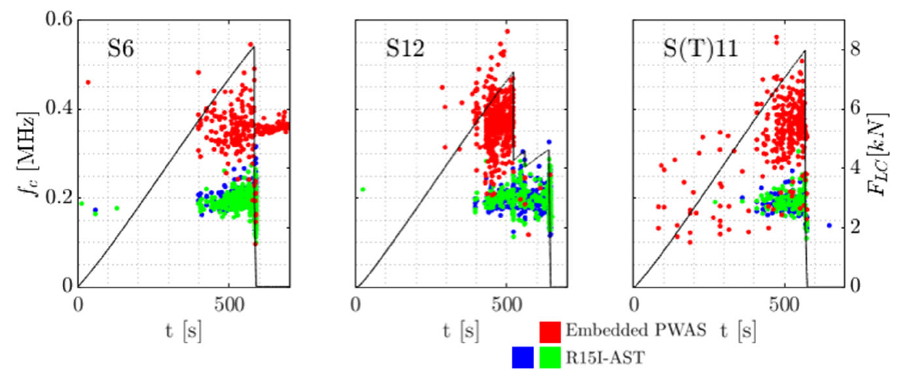
Figure 8. Centroid frequency f c of all measured signals over time and load cell force F LC for the small ‘S’ and ‘ST’ embedded sensors and the two R15I-ASTs.